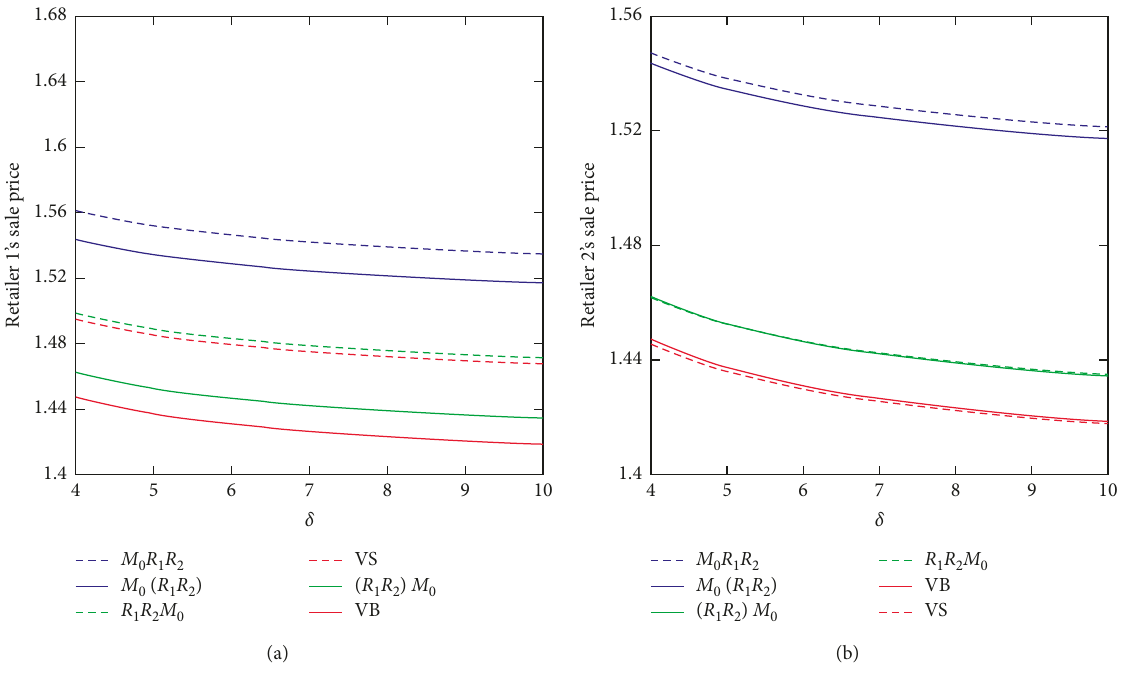
Figure 7: Effect of δ on the retail price in decentralized models.